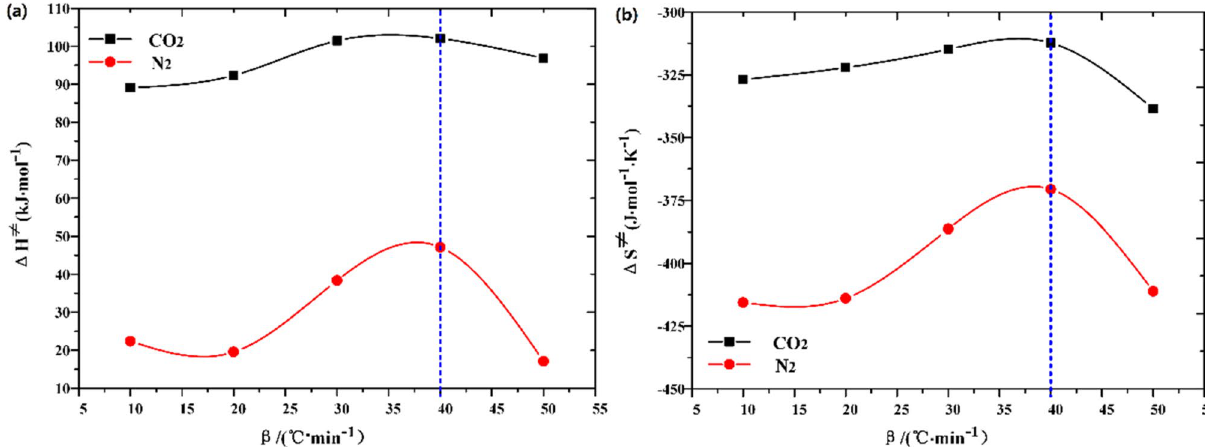
Figure 11. ( a ) Activation enthalpy and ( b ) activation entropy varies with heating rate.